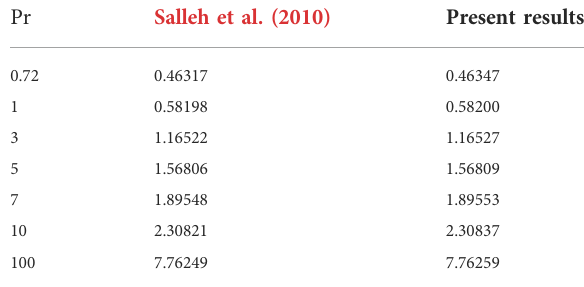
TABLE 1Thermophysical properties ofthe base fl uidand nanoparticle (Rana and Bhargava, 2011). Property